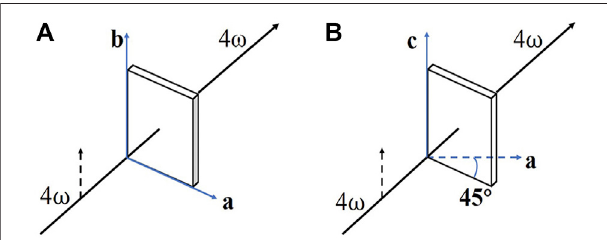
FIGURE 5 | Diagram of the polarization direction of FHG laser [ (A) : z-cut sample; (B) FHG sample. The black dotted arrow shows the polarization direction of incident